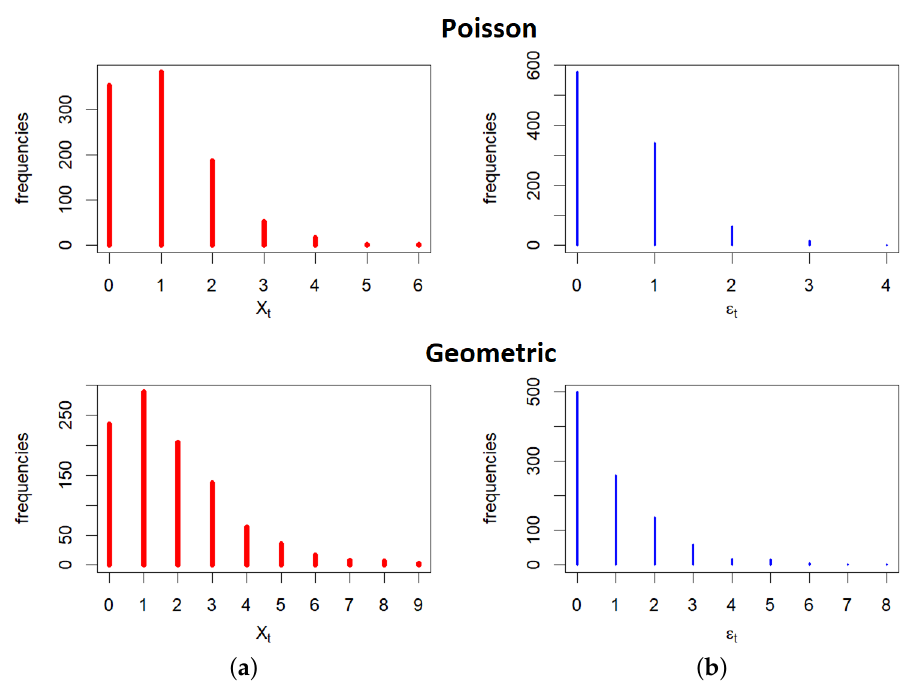
Figure 2. Plots of the sample frequency distributions of INAR(1) processes ( a ) and their innovations ( b ) with Poisson distribution (plots above) and geometric distribution (plots below). True parameters’ values are θ = α =